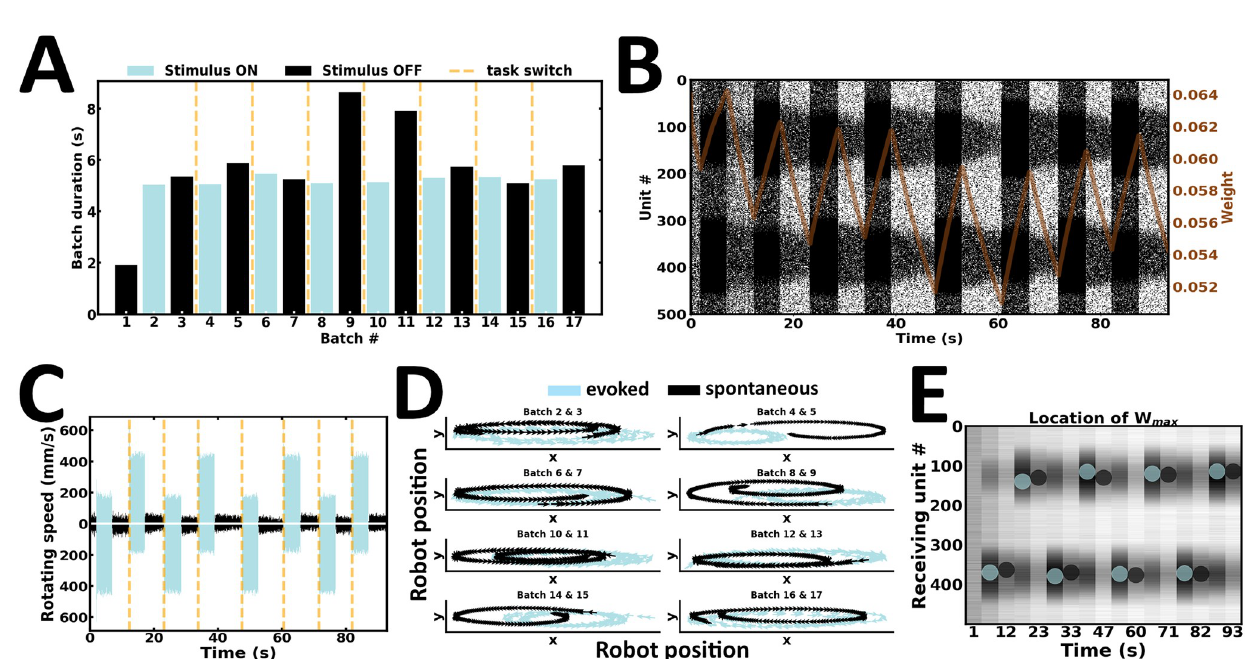
Fig 10. Task switching. (A) Duration of evoked and spontaneous batches. (B) Raster plot of network activity. Stimulus configuration shapes local persistent activity; brown curve, average synaptic efficacy. (C) Rotating speed of left and right wheel motors as a function of time. (D) Motor trajectory of the robot during subsequent pairs of evoked and spontaneous activity. (E) Spatial location of the highest average incoming synaptic weights; blue and black dot, evoked and spontaneous activity, respectively. https://doi.org/10.1371/journal.pone.0244822.g010 PLOS ONE | https://doi.org/10.1371/journal.pone.0244822 January 5,